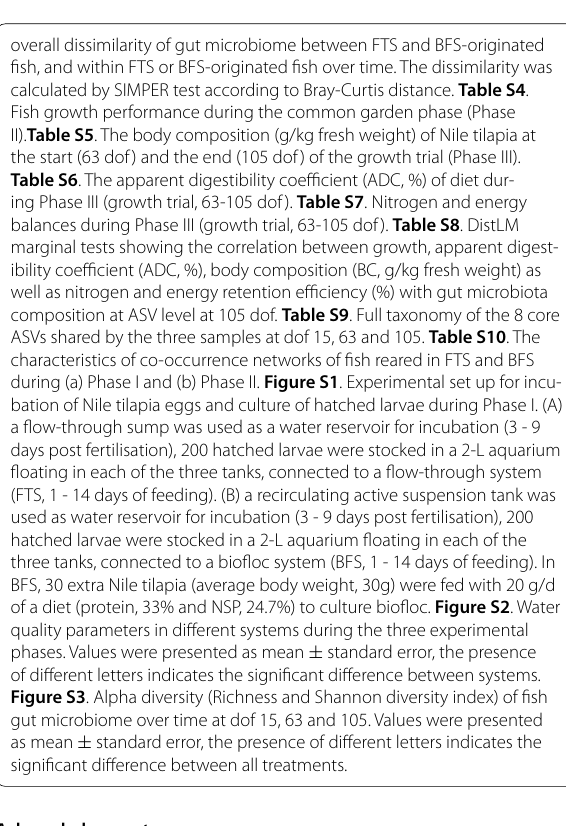
Figure S3 . Alpha diversity (Richness and Shannon diversity index) of fish gut microbiome over time at dof 15, 63 and 105. Values were presented as mean standard error, the presence of different letters indicates the ± significant difference between all